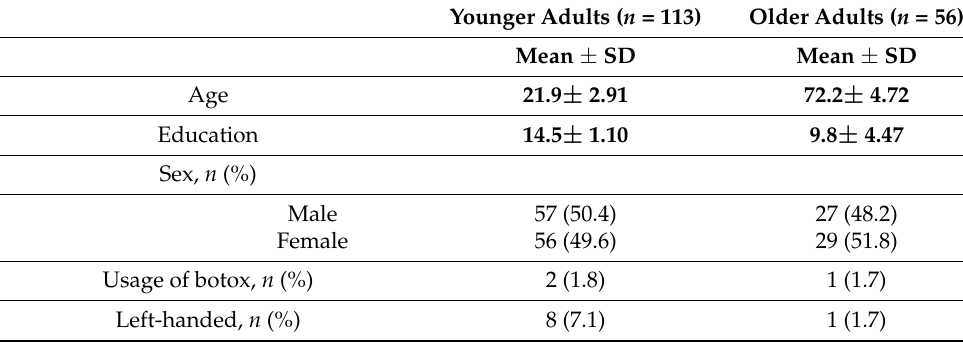
Table 1. Demographic characteristics across the